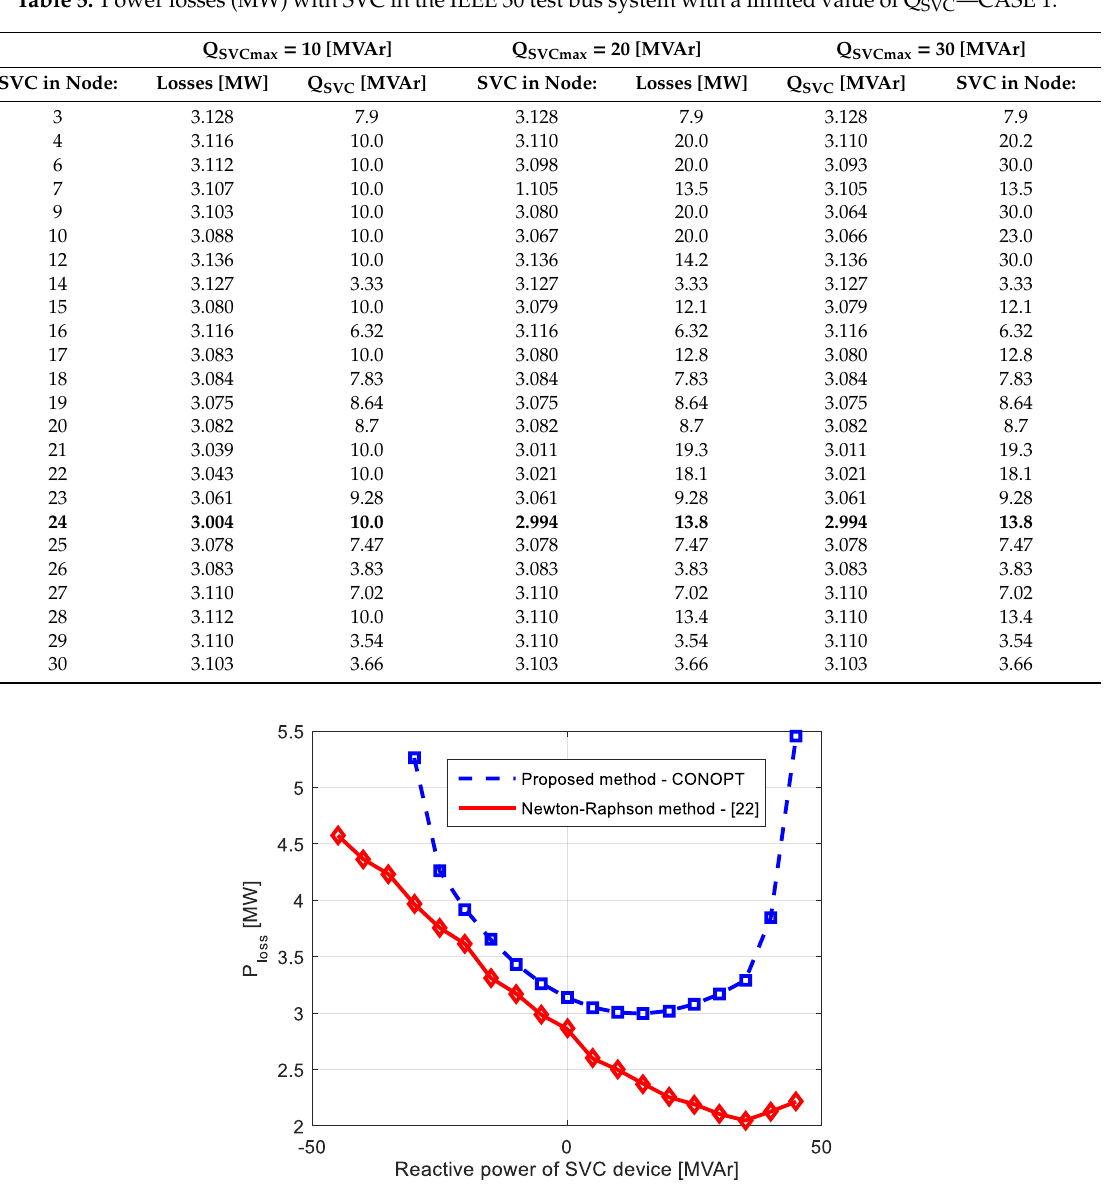
Figure 7. The impact of the reactive power of SVC devices located in node 24 on power system losses in the IEEE 30 test bus system.